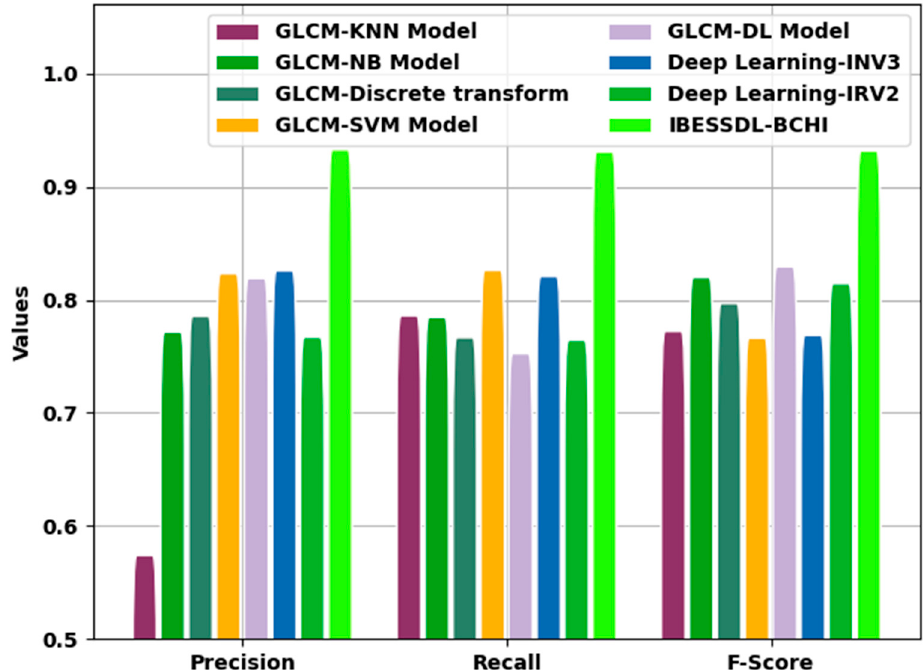
Figure 11. Comparative analysis outcomes of the proposed IBESSDL-BCHI approach and other existing methodologies.